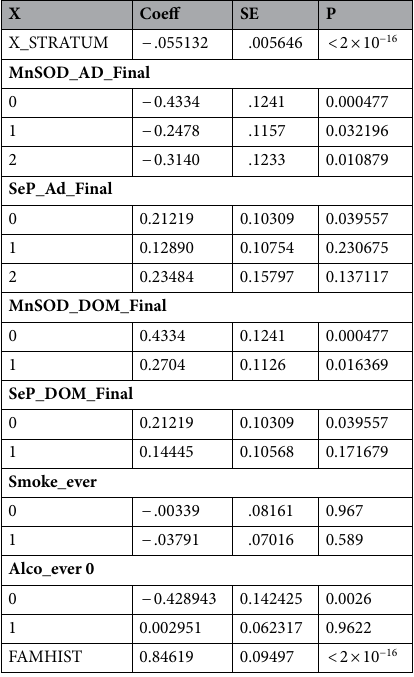
Table 1. Simple logistic regression results dependent variable CURRENTSTATUS intercepts are not listed.